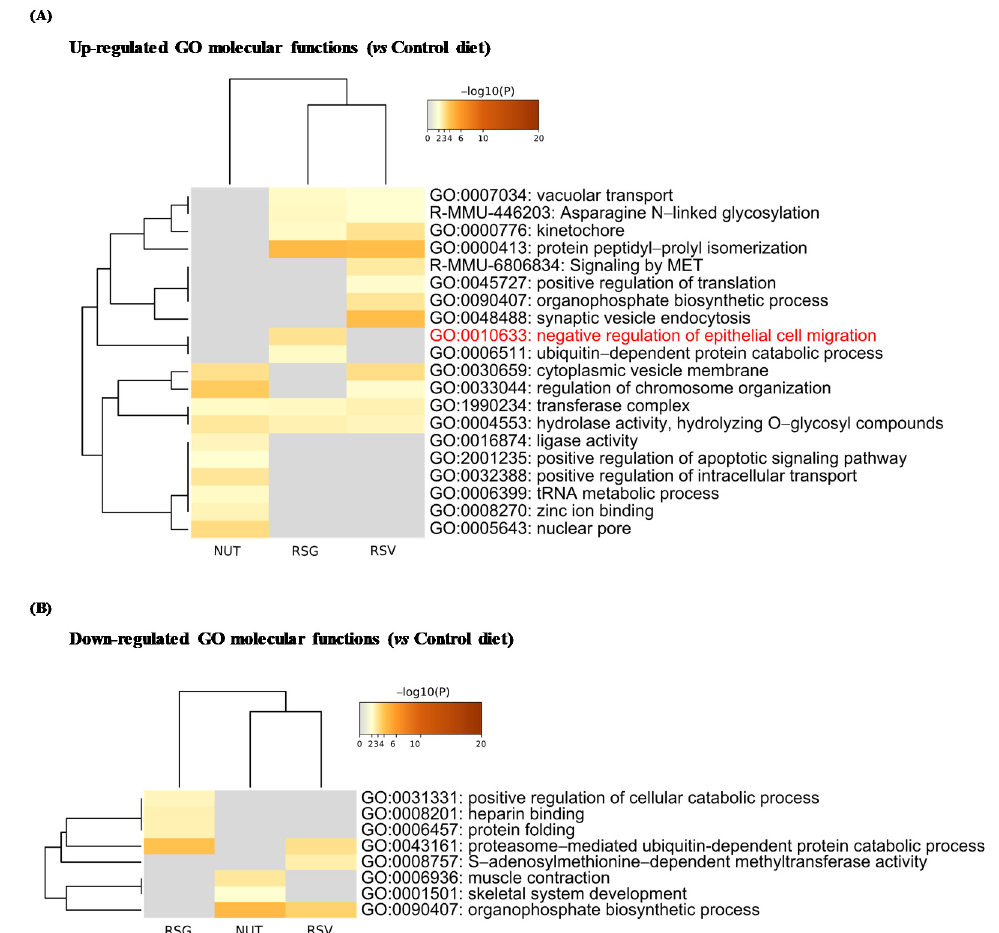
Figure 5. Enrichment analysis of Gene Ontology (GO) molecular functions in differentially up- and down-regulated proteins from lasered mice retina. Based on ANOVA results, t -tests with Welch correction were further applied to identify significantly up- and down-regulated proteins in RSG, NUT, and RSV groups compared with the control diet group (Co). Metascape database was then used to identify Gene Ontology (GO) enriched molecular functions in up- ( A ) and down-regulated DEPs ( B ). Heatmaps show the top enriched molecular functions in up-regulated ( A ) and down-regulated DEP ( B ) term clusters, colored by − log 10 ( p -value). Threshold: 0.3 kappa score; similarity score > 0.3. The darker the orange is, the more significant the term. Gray color indicates a lack of significance.